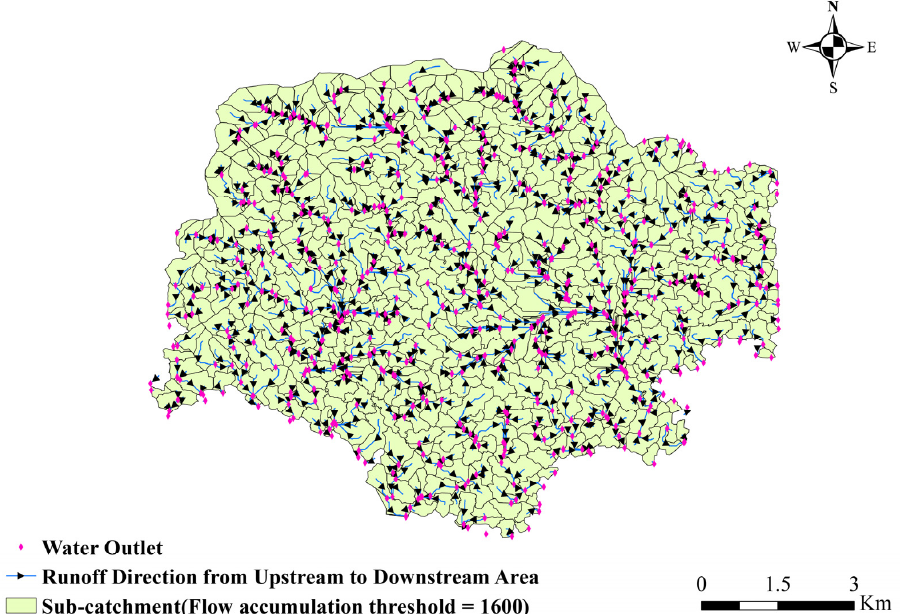
Figure 10. Runoff connectivity between the 596 sub-catchments.